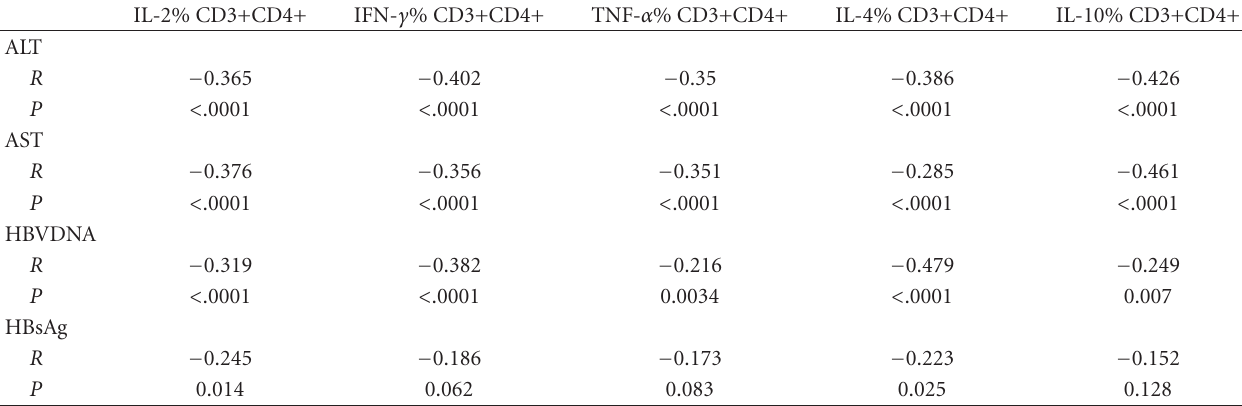
Table 4: Correlation between intracellular Th1/Th2 cytokines and ALT, AST, HBV DNA load, and HBsAg.